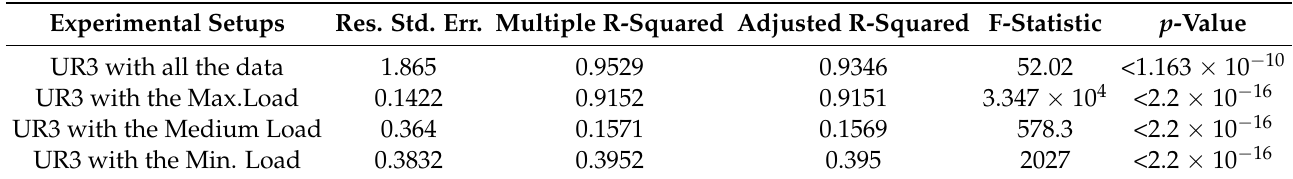
Figure 13. Temperature prediction results under different conditions. Table 4. Performances of the general linear model when predicting the cobot temperature.